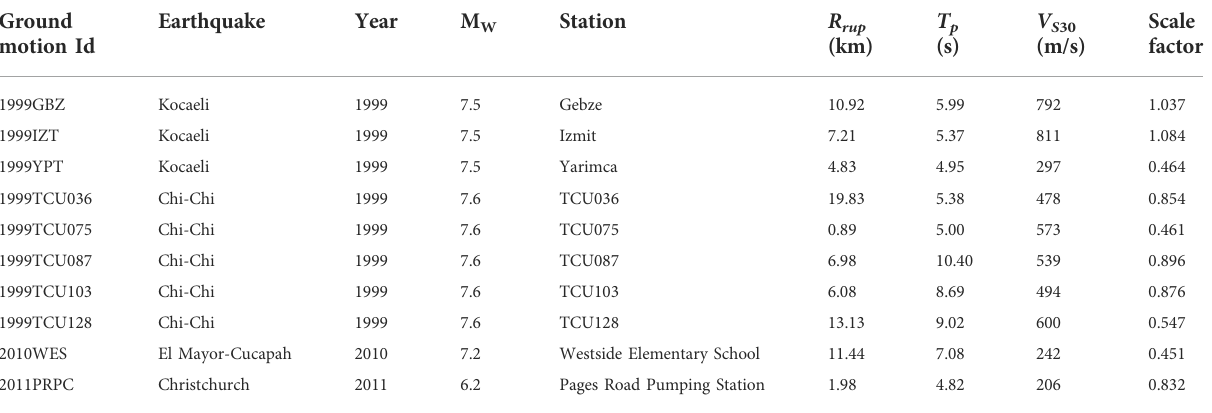
TABLE 1 List of the ground motion groups investigated in the present study. Ground motion